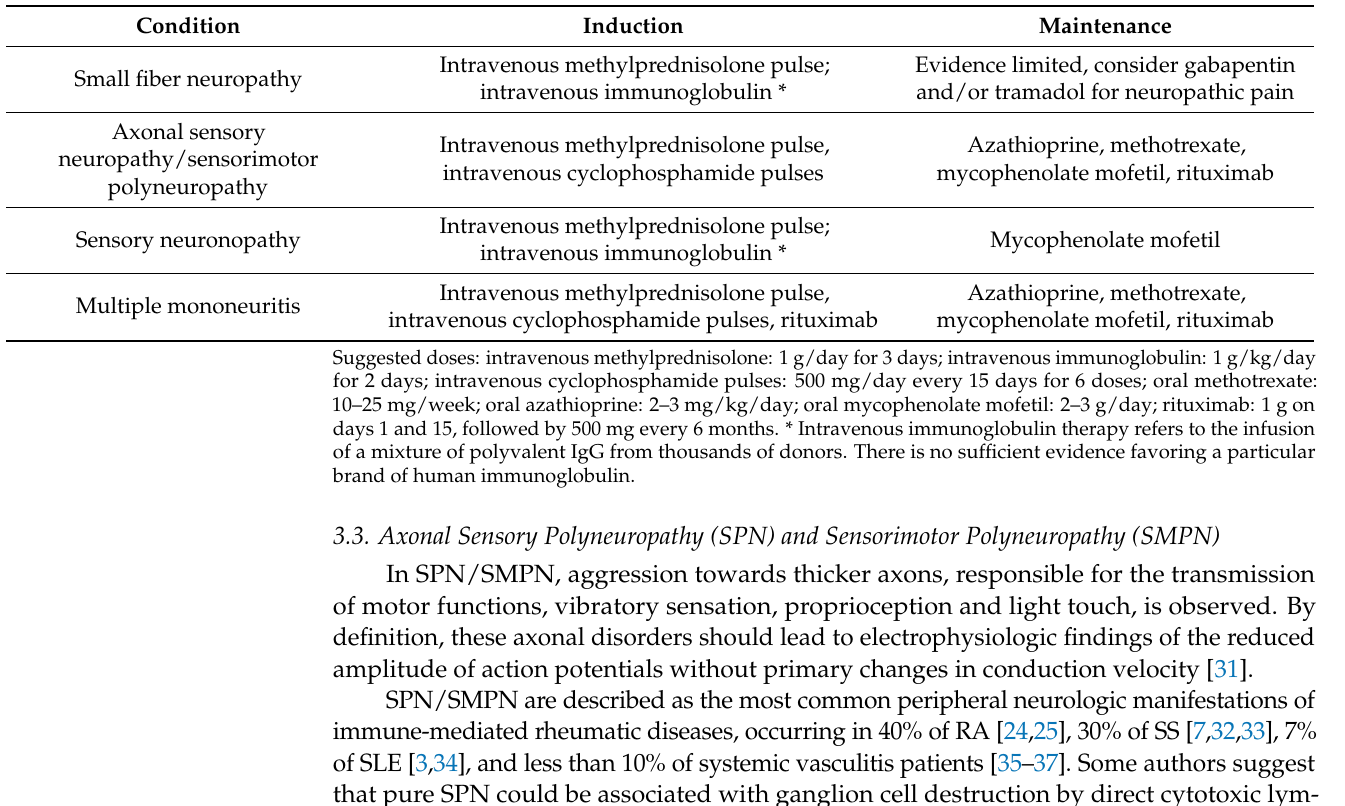
Table 1. Suggested schemes for induction and maintenance of remission of the discussed autoimmune rheumatic-disease-related